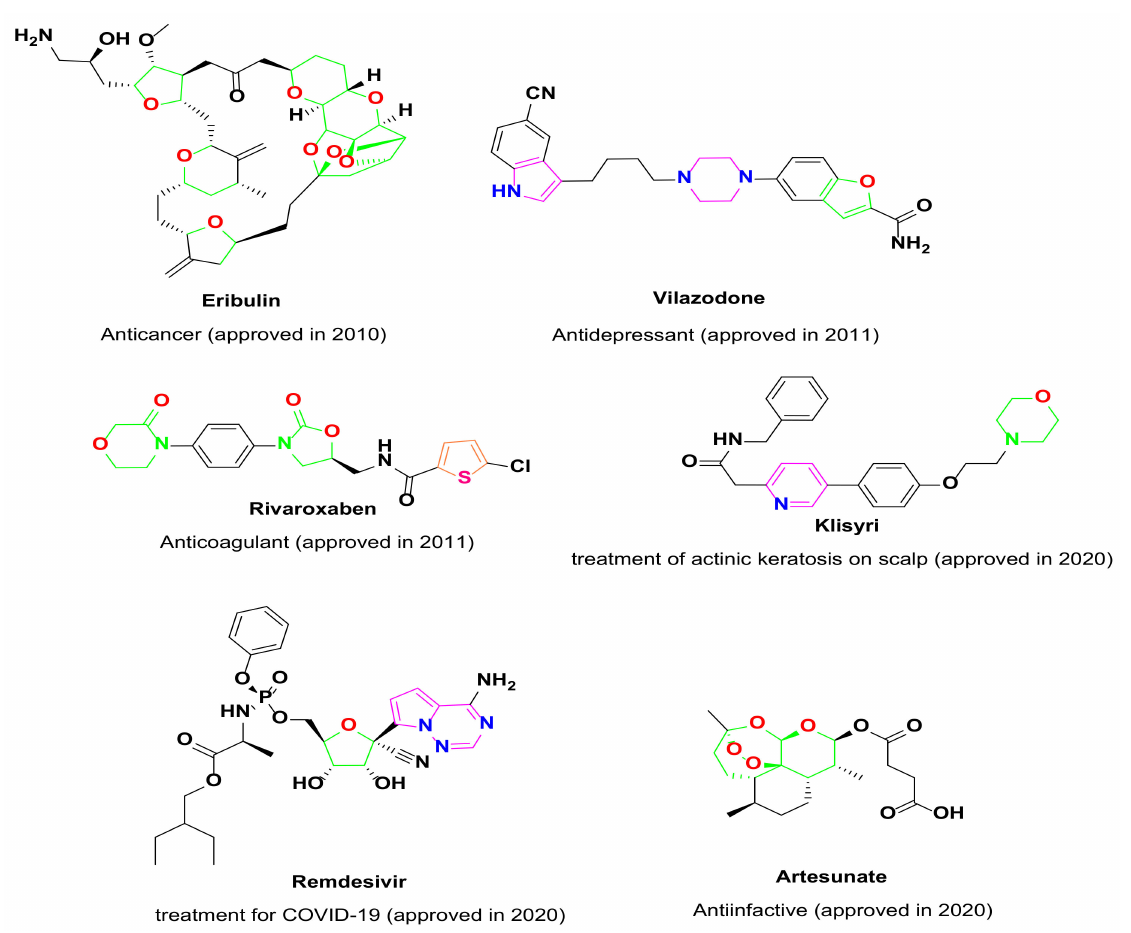
Figure 1. FDA-approved heterocyclic